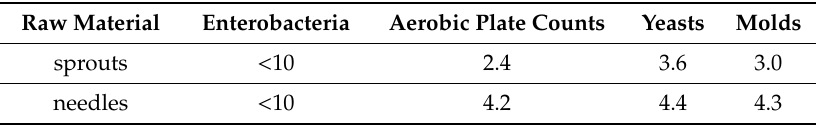
Table 2. Microbial quality of freshly collected Norway spruce sprouts and older needles. Colony counts log 10 (colony forming units (cfu) / g) fresh weight (N = 1). Raw Material Enterobacteria Aerobic Plate Counts